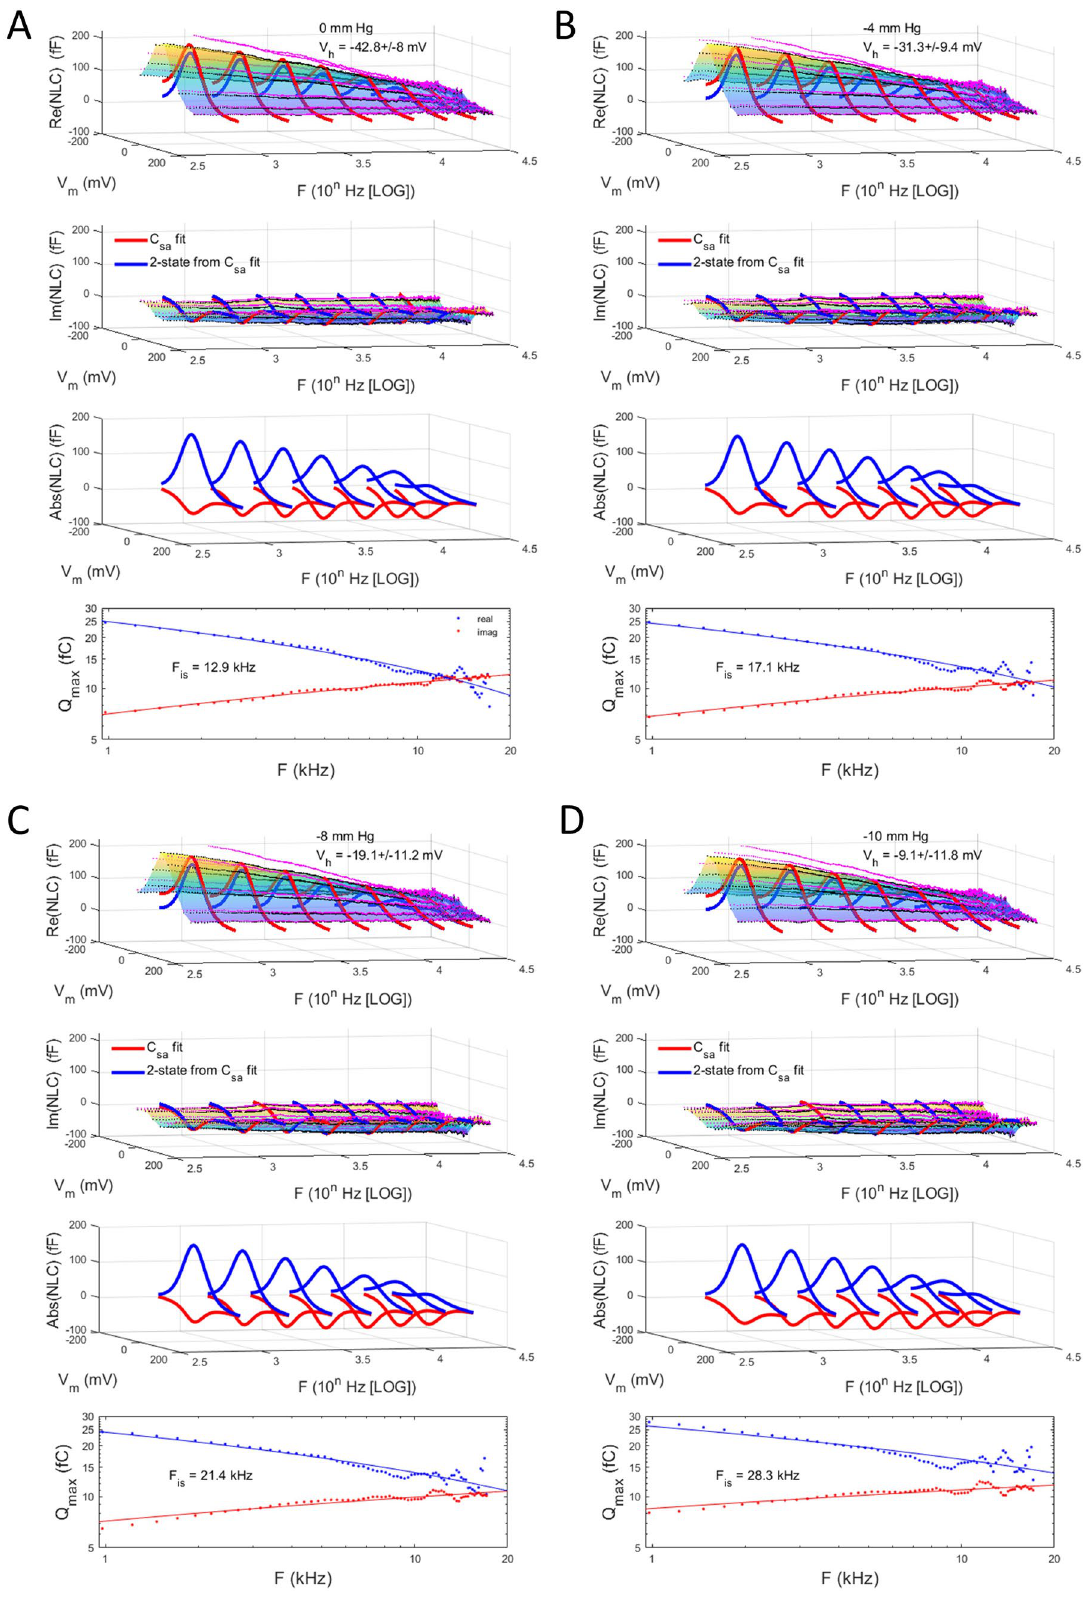
Figure 7. Effects of membrane tension on complex NLC. Pipette pressure was set to (A) 0 mmHg, (B) − 4 mmHg, (C) − 8 mmHg, and (D) − 10 mmHg. Responses are characterized as in Fig. 1 legend. The bottom panels show that F is increases as tension